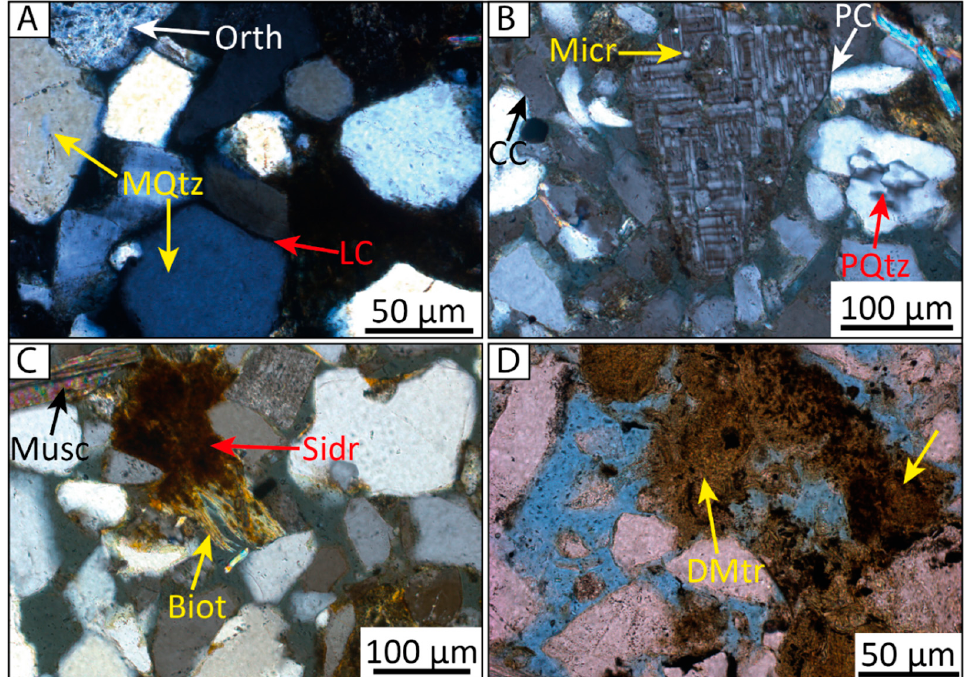
Figure 4. Thin-section photomicrographs showing detrital grains, matrix, cement, and types of grain contacts for the Forties Sandstone Member. ( A ) Cross-polarized-light photomicrograph showing monocrystalline quartz (MQtz), partly altered orthoclase (Orth), and long-grain contacts (LC). ( B ) Cross-polarized-light photomicrograph showing microcline (Micr), polycrystalline quartz (PQtz), point contacts (PC), and concavo-convex contacts (CC). ( C ) Cross-polarized-light photomicrograph showing detrital muscovite (Musc), detrital biotite (Biot), and siderite (Sidr). ( D ) Plane-polarized-light photomicrograph showing greenish-brown, smectitic detrital matrix. Table 1. Statistical summary of petrographic and petrophysical parameters of the Forties Sand- stone Member. Point Count and Petrophysical Data